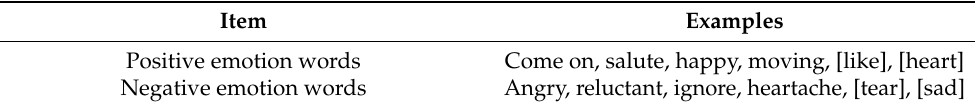
Table 2. Examples of emotion words. Item